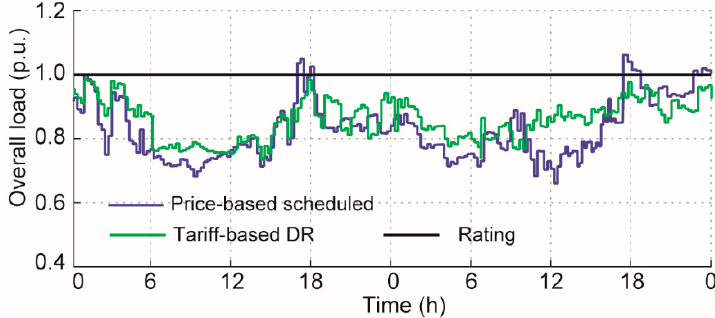
Figure 8. Simulated network load for two consecutive days.